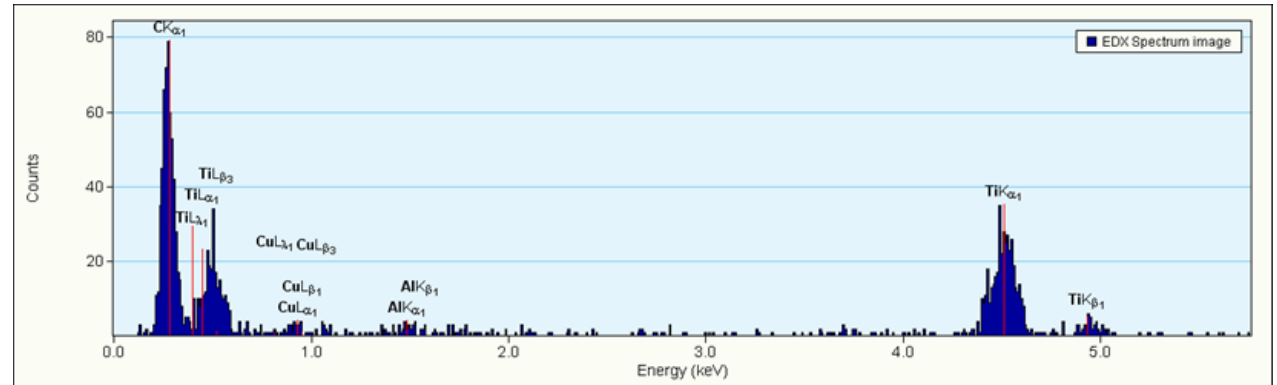
Figure 3. STEM/HAADF image of cross-section microstructure of surface TiN layer with frag- ments of twisted nano-whisker over it formed on PN and C coated Ti-6Al-7Nb alloy ( a ) as well as accompanying maps presenting distribution of Ti, Al, Nb, N and O ( b – f ) elements.